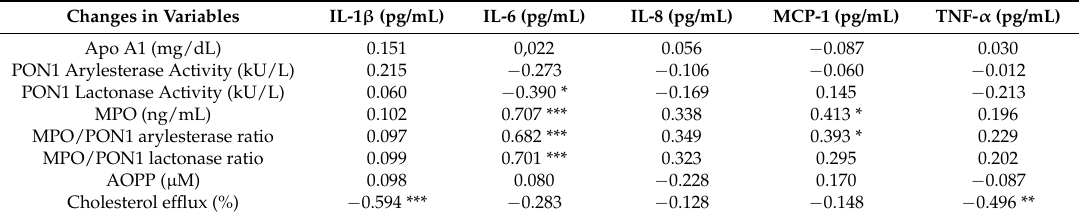
Table 4. Correlations 1 between changes in high-density lipoprotein (HDL) function and inflammation markers after agraz consumption, compared to placebo, in women with metabolic syndrome.